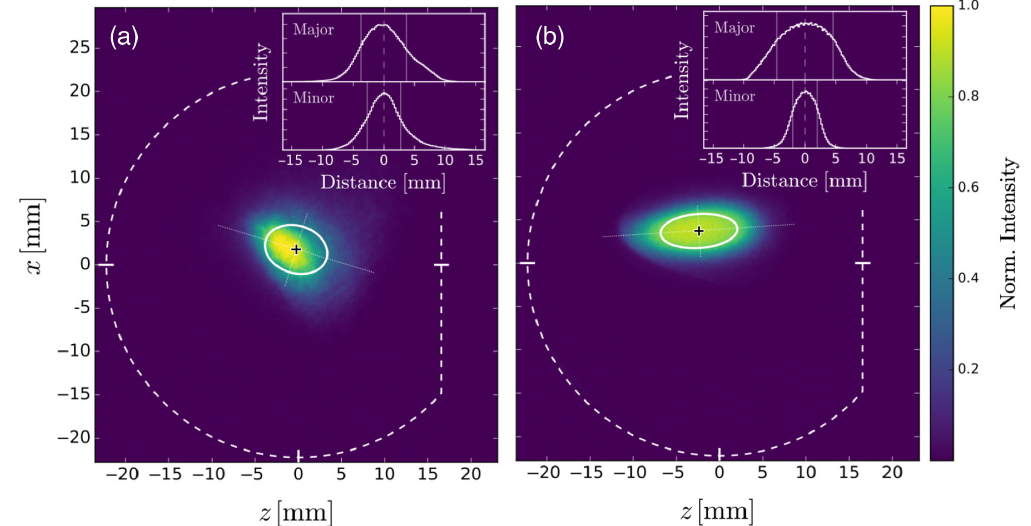
FIG. 11. MCP images showing the transverse beam profiles of (a) antiprotons and (b) positrons measured at the LDS. The dashed line shows the visible active area of the MCP. The solid white lines show the elliptical (one sigma) beam envelopes, with major and minor axes indicated by dotted lines. The inset figures show the beam intensity integrated along the major and minor axes of each ellipse. The directions of the x and z axes are defined in Fig.